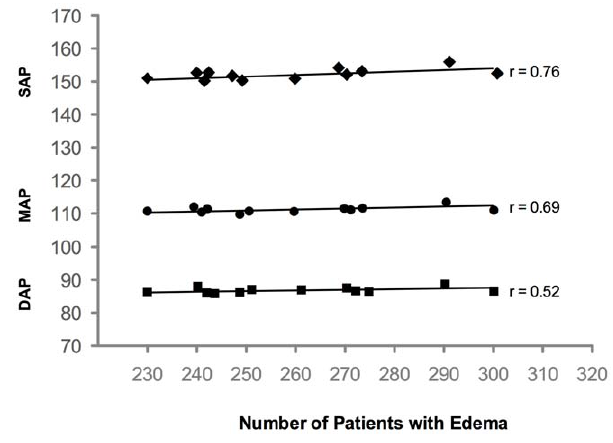
Figure 5. The increase in blood pressure levels correlates positively to the number of patients with edema.